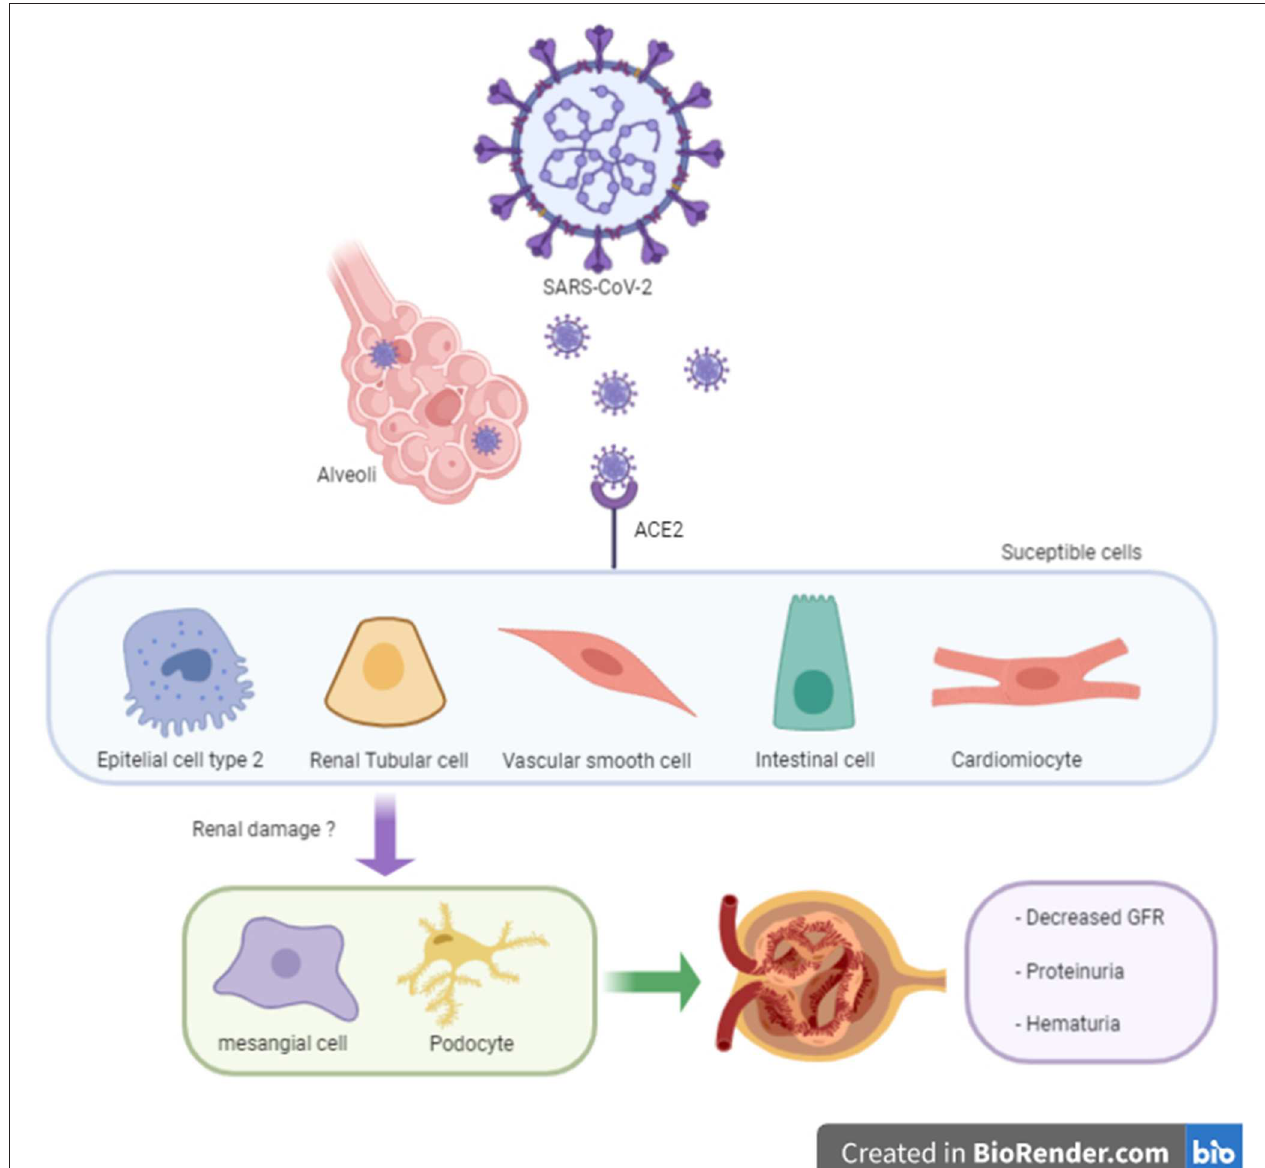
FIGURE 1 | SARS-CoV-2 in susceptible cells expressing ACE2 and unknown renal